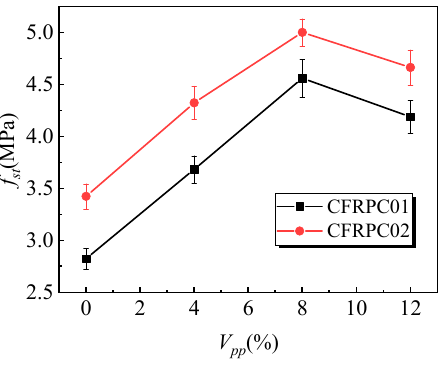
Figure 9. Effect of the polymer–cement ratio on the splitting tensile strength. Figure 9. E ff ect of the polymer–cement ratio on the splitting tensile